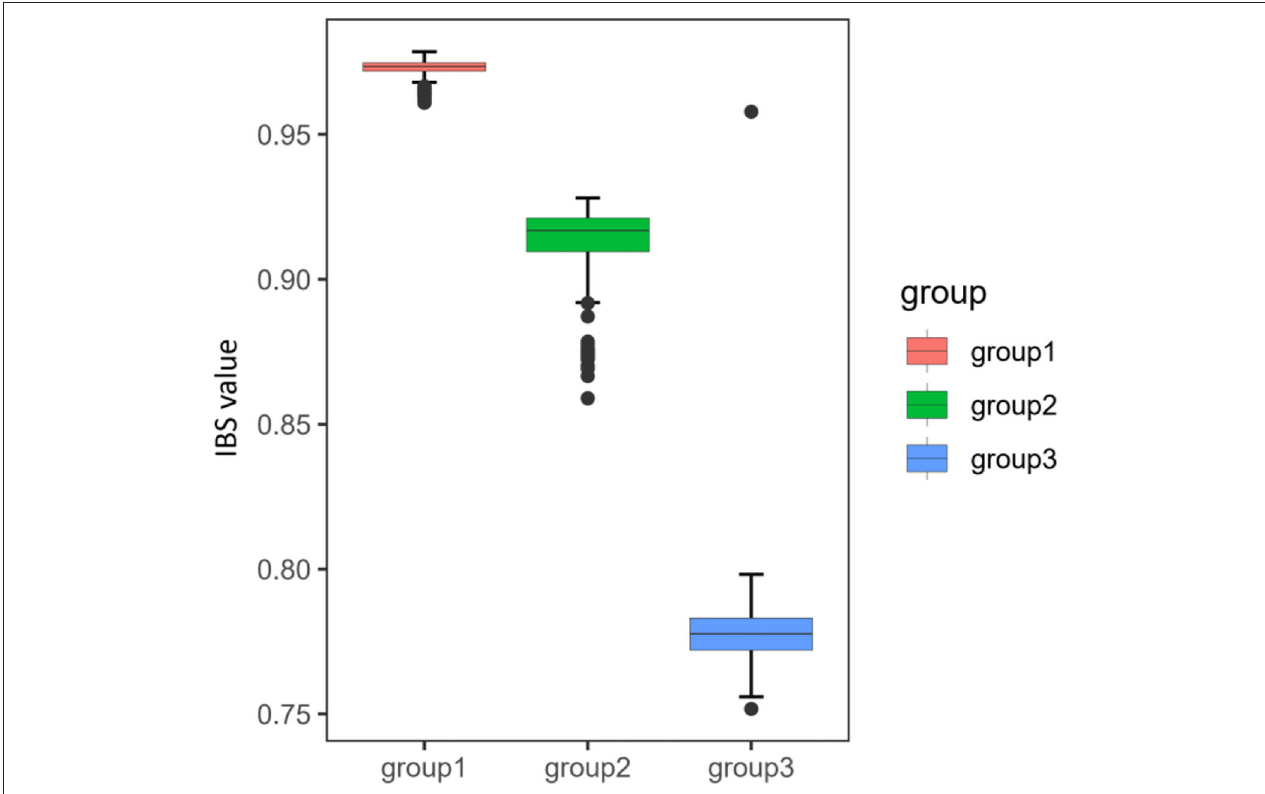
FIGURE 3 | Genetic similarity within three distinct groups by identity-by-state (IBS). The upper and lower ranges of the boxplot, with the upper limit being the upper quartile and the lower limit being the lower quartile. The horizontal line inside the box represents the median. The whiskers were extended to the 95th percentile.